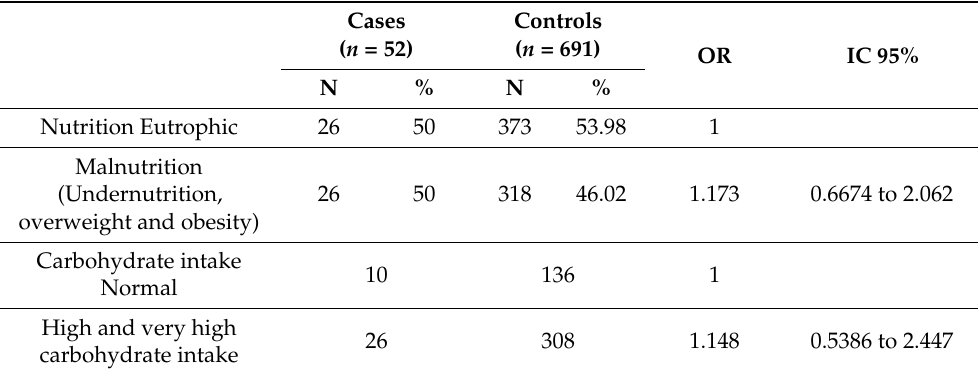
Table 2. Risk factors for the presence of oral Candida